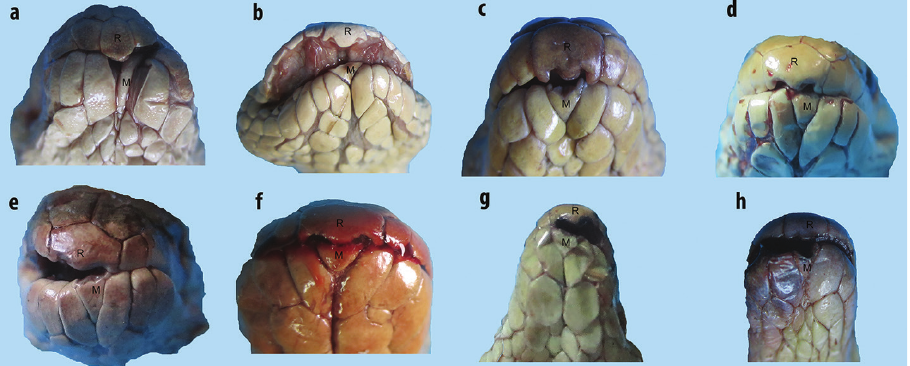
Figure 3. Rostrals and mentals of sea snakes of the genus Hydrophis in the Persian Gulf and Gulf of Oman: a tip of rostral decurved, pointed and beaked shaped, mental narrow, elongate and dagger-shaped ( Hydrophis schistosus ) b and c tip of rostral markedly tridentate, mental short and triangulate ( H. viperinus and H. curtus , respectively) d tip of rostral markedly unidentate, mental short and triangulate ( H. ornatus ) e–h tip of rostral slightly unidentate, mental short and triangulate ( H. ornatus , H. spiralis , H. cyanocinctus and H. platurus ,